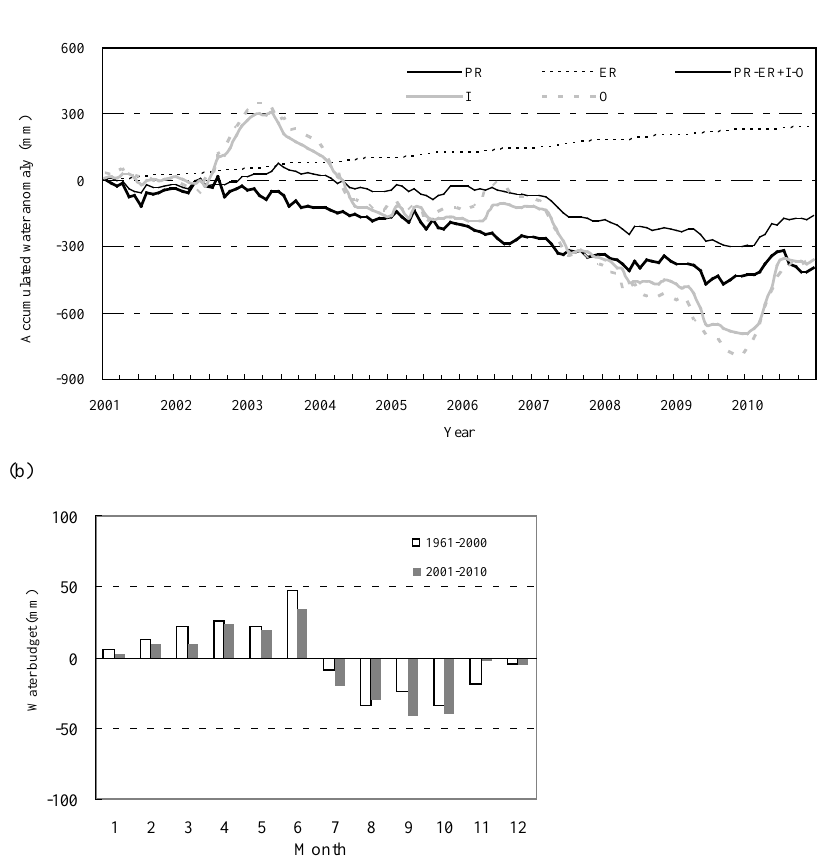
Figure 6. (a) Accumulated anomaly of water components and (b) water budget at the Poyang Lake region for period 2001–2010 compared to 1961–2000. All the water amounts are normalized to equivalent water height of the whole Poyang Lake